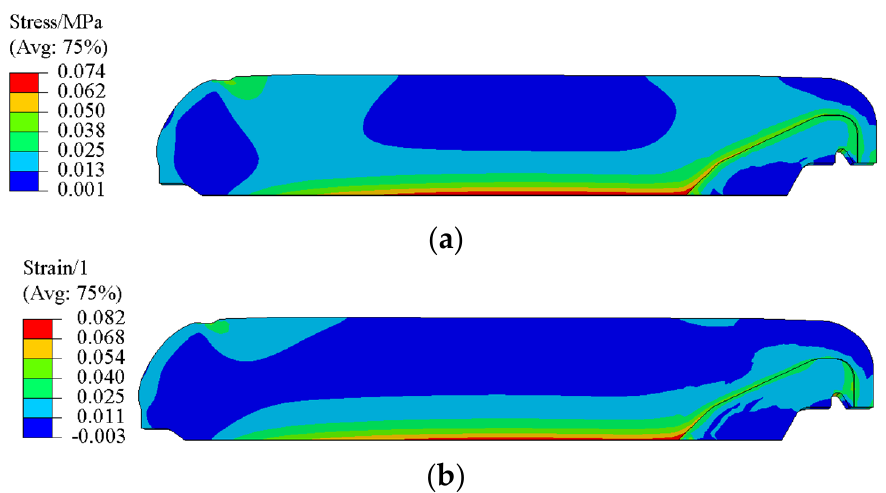
tot σ during the cooling process. ( b ) Contours of